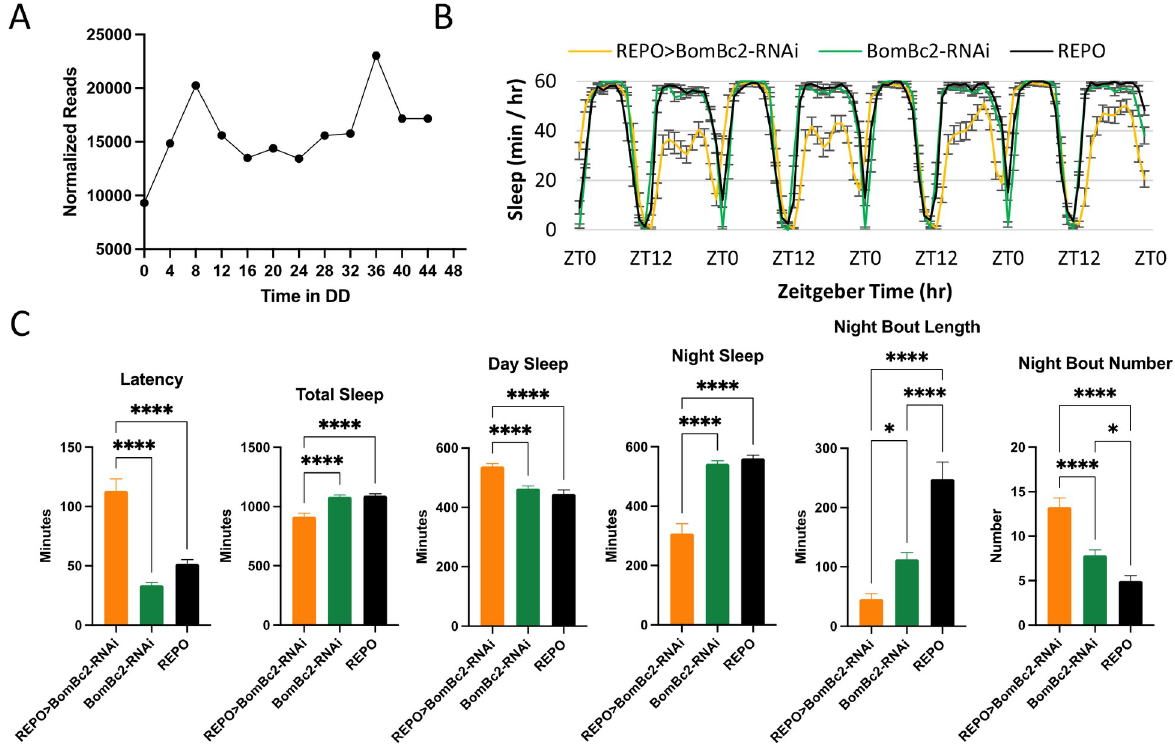
Fig 4. BomBc2 is required in glia for normal sleep behavior. A) Normalized read count across two days in DD derived from the astrocyte TRAP. Results are averages of two data sets per time point. B) Average sleep behavior across three days for REPO > BomBc2-RNAi (orange, n = 30), BomBc2-RNAi (green, n = 30), and REPO (black, n = 30). C) Average latency, total sleep, day sleep, night sleep, night bout length, and night bout number. Results are mean ± SEM, One-way ANOVA, � p < 0.05, ���� p < 0.0001.